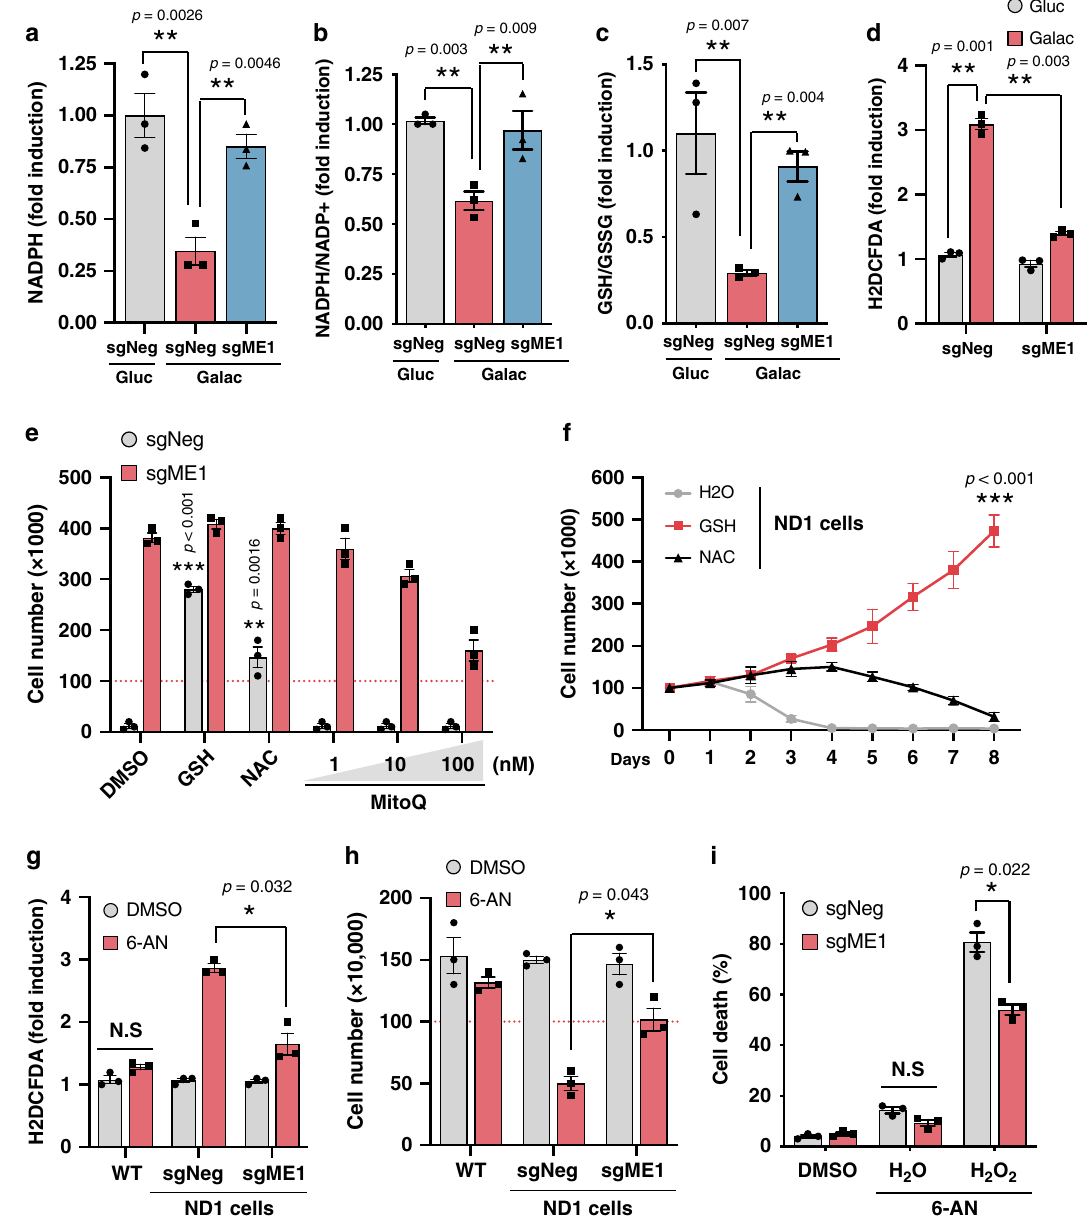
Fig. 3 Complex I disease mutations reduce levels of NADPH and GSH and cause oxidative stress. a Relative NADPH levels analyzed by LC-MS, b NADPH/NADP + ratio, c GSH/GSSG ratio, and d relative reactive oxygen species (ROS) levels measured using dichlorodihydro fl uorescein diacetate (H2DCFDA) in sgNeg and sgME1 ND1 mutant cells cultured under glucose or galactose conditions for 48 h ( n = 3). e Cell number of galactose-grown ND1 cells (96 h) supplemented with GSH (2 mM), NAC (4 mM), or the indicated doses of MitoQ ( n = 3). f – i Growth curves in galactose-grown ND1 cells treated with GSH or NAC. 6-Aminonicotinamide (6-AN) (100 μ M) was used to inhibit PPP ( n = 3), and g ROS levels, h cell number, and i H 2 O 2 -induced cell death was assessed after 48 h in WT cells ( n = 3). Experiments are represented as means± SEM., n > 3 biological replicates. Asterisks denote * p < 0.05, ** p < 0.01, or *** p < 0.001. Two-way ANOVA in a – d , g – i and paired two-tailed Student ’ s t test in e , f . Gluc glucose, Galac galactose. Red dashed lines indicate initial seeding